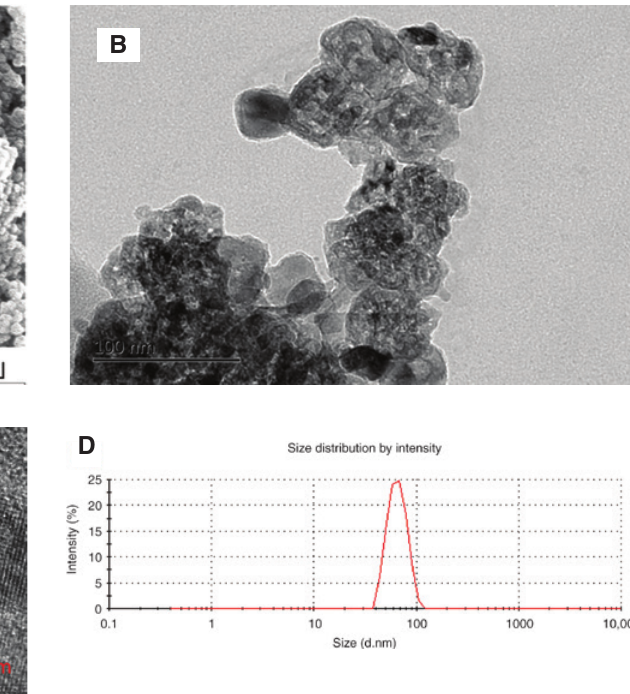
Figure 4 shows the relationship between the predicted and experimental values. The R square is 0.987, indicat- ing that the predicted results are in good agreement with experimental results.